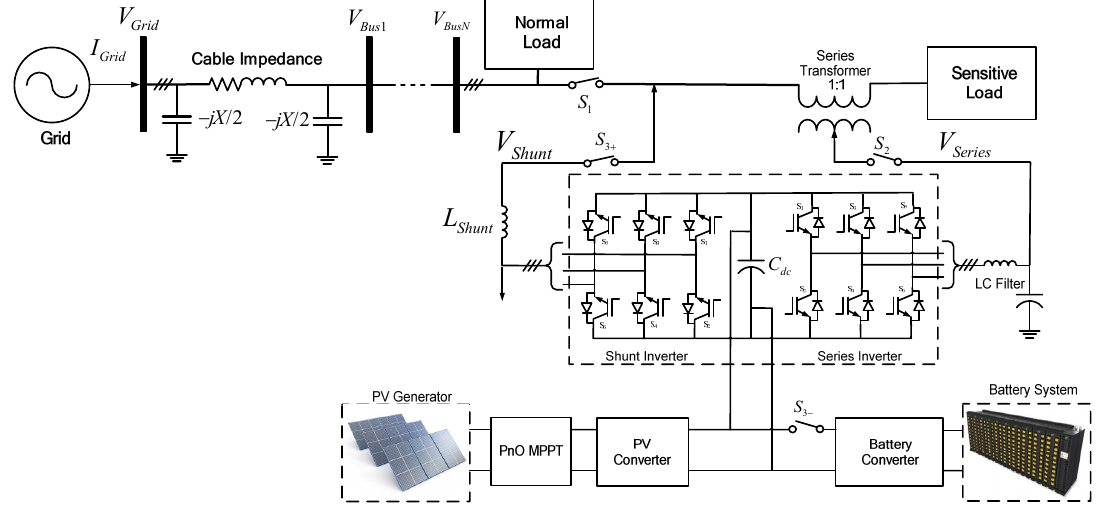
Figure 4. Proposed PV system for voltage compensation method.